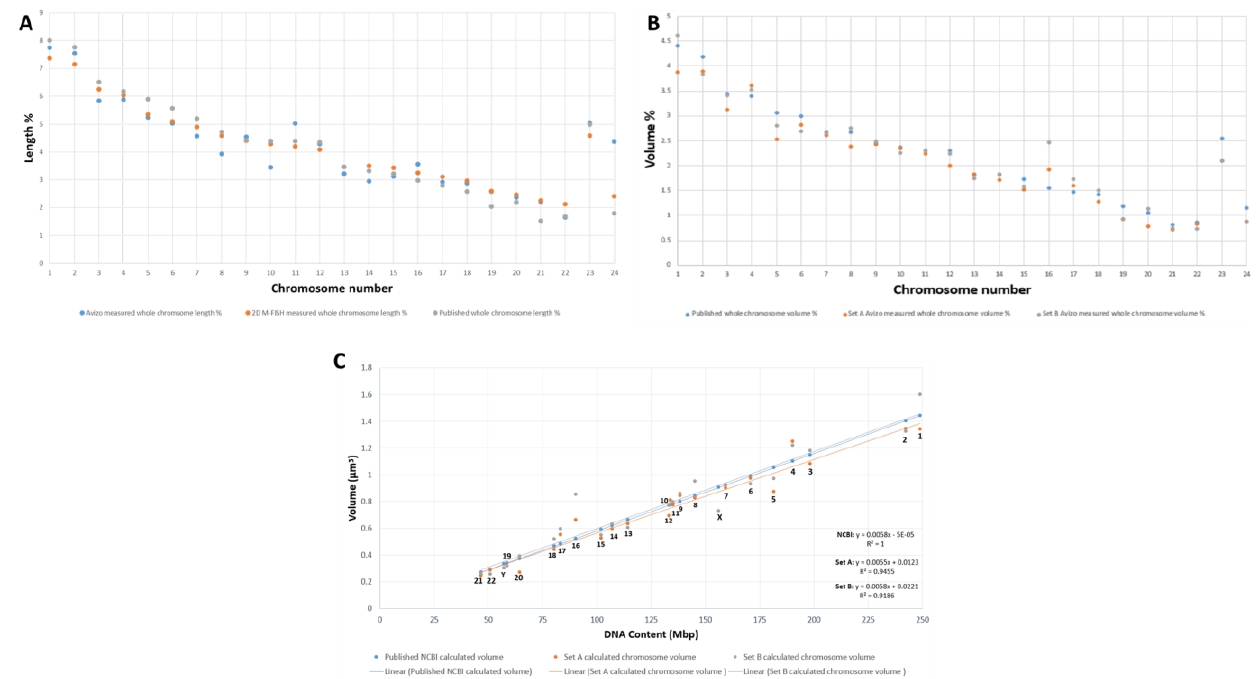
Figure 3. Validation parameters of 46 chromosomes after SBFSEM and Avizo segmentation. ( A ) Comparing the length of our measured chromosomes with length measurements of our mFISH 2D spread chromosomes and published chromosome length data [43]. ( B ) Comparing the volume of both homologs (set A and set B) of our measured chromosomes with published chromosome volume measurement [44]. ( C ) Comparison of published and our measured chromosome volumes of both homologs (set A and set B) versus the number of base pairs of the accordingly assigned chromosomes from the human genome sequence [3].